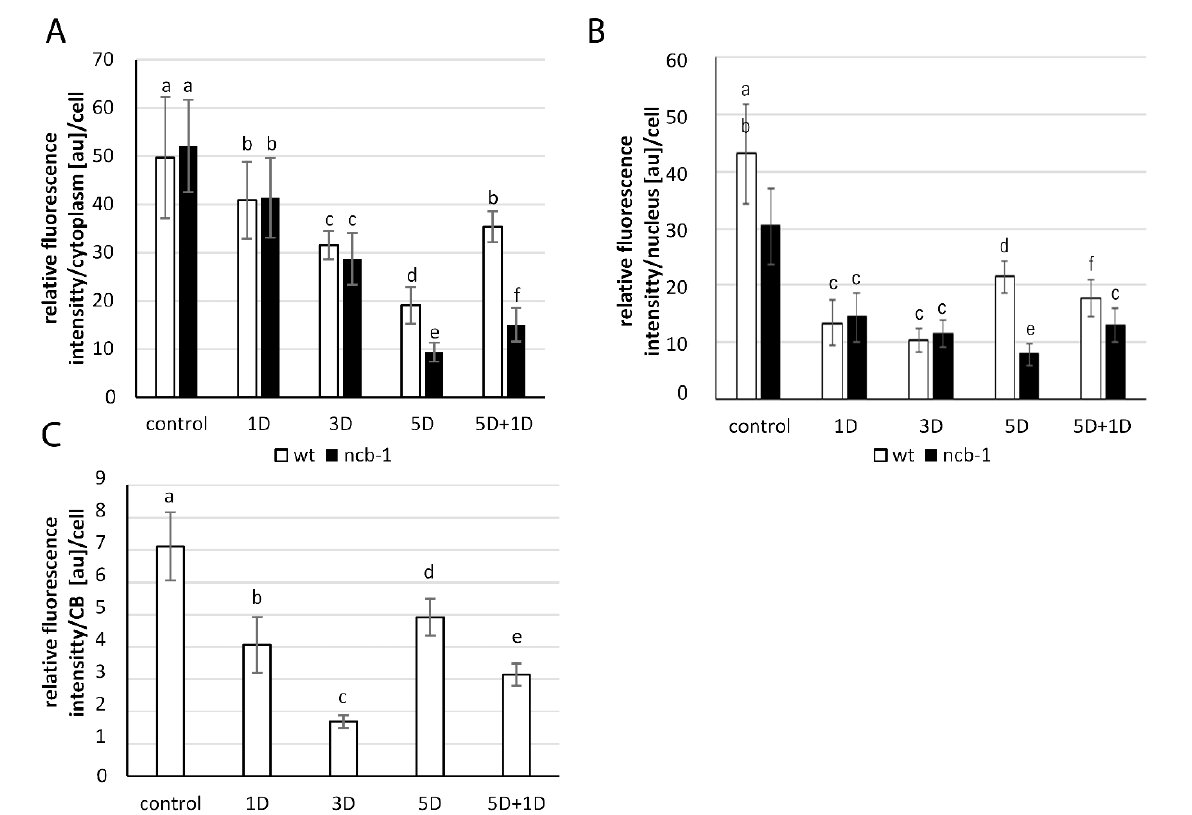
Figure 3. The relative fluorescence intensity of poly(A + ) RNA in cytoplasm ( A ), nucleus ( B ), CBs ( C ). X-axis—1, 3, 5D—days of hypoxia, 5D + 1D—5 days hypoxia and 1-day reoxygenation. Variants labeled with the same letters are not significantly different ( p ≤ 0.05).